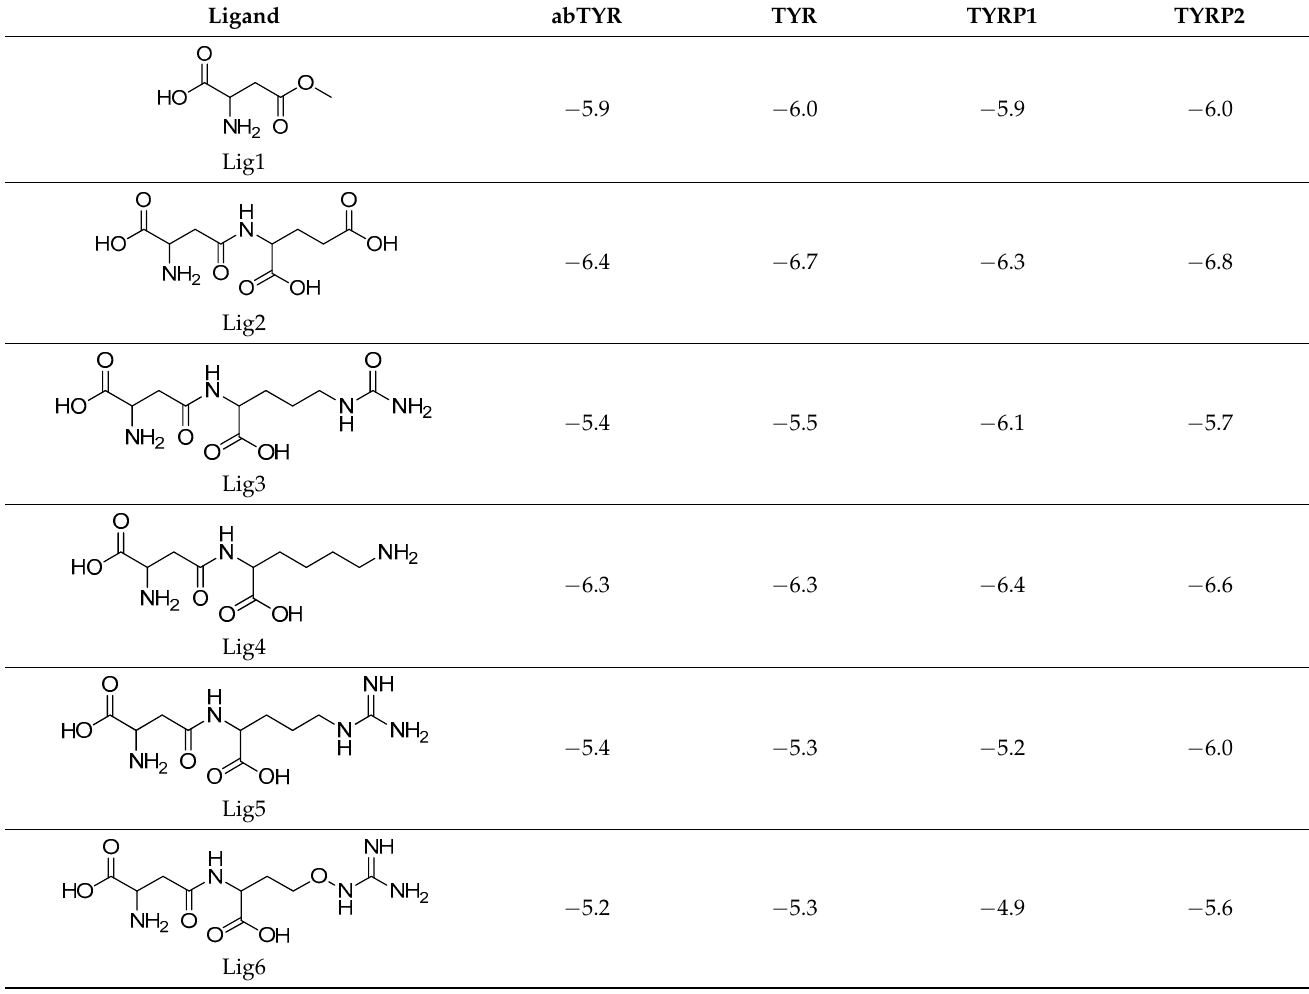
Table 1. The binding affinity values obtained for selected ligands in complex with tyrosinase enzymes reported in kcal · mol − 1 .